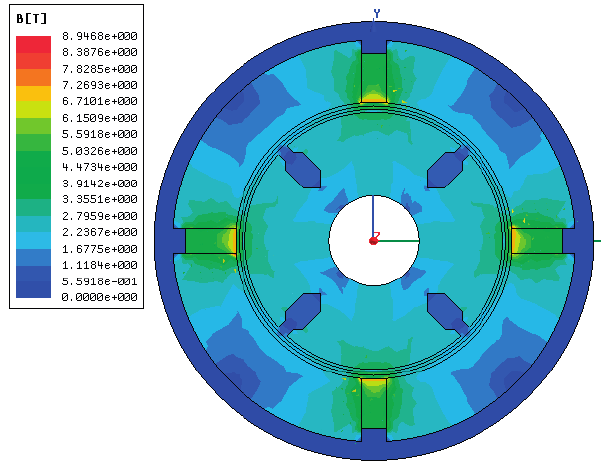
Figure 9. Density cloud distribution of flux Ф P